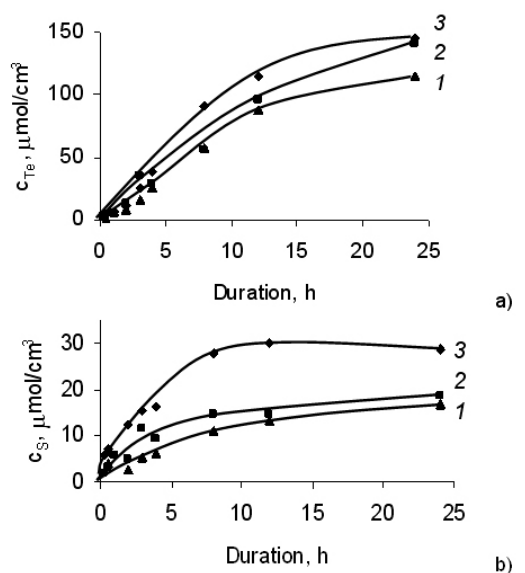
Figure 3. Changes of tellurium (a) and sulfur (b) concentrations